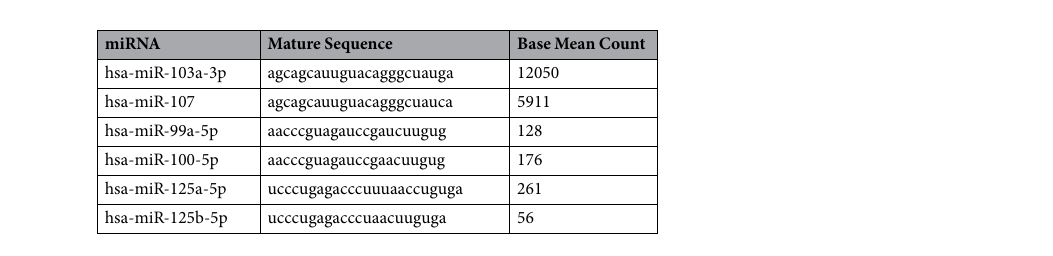
Table 2. Clustered miRNAs share highly similar mature